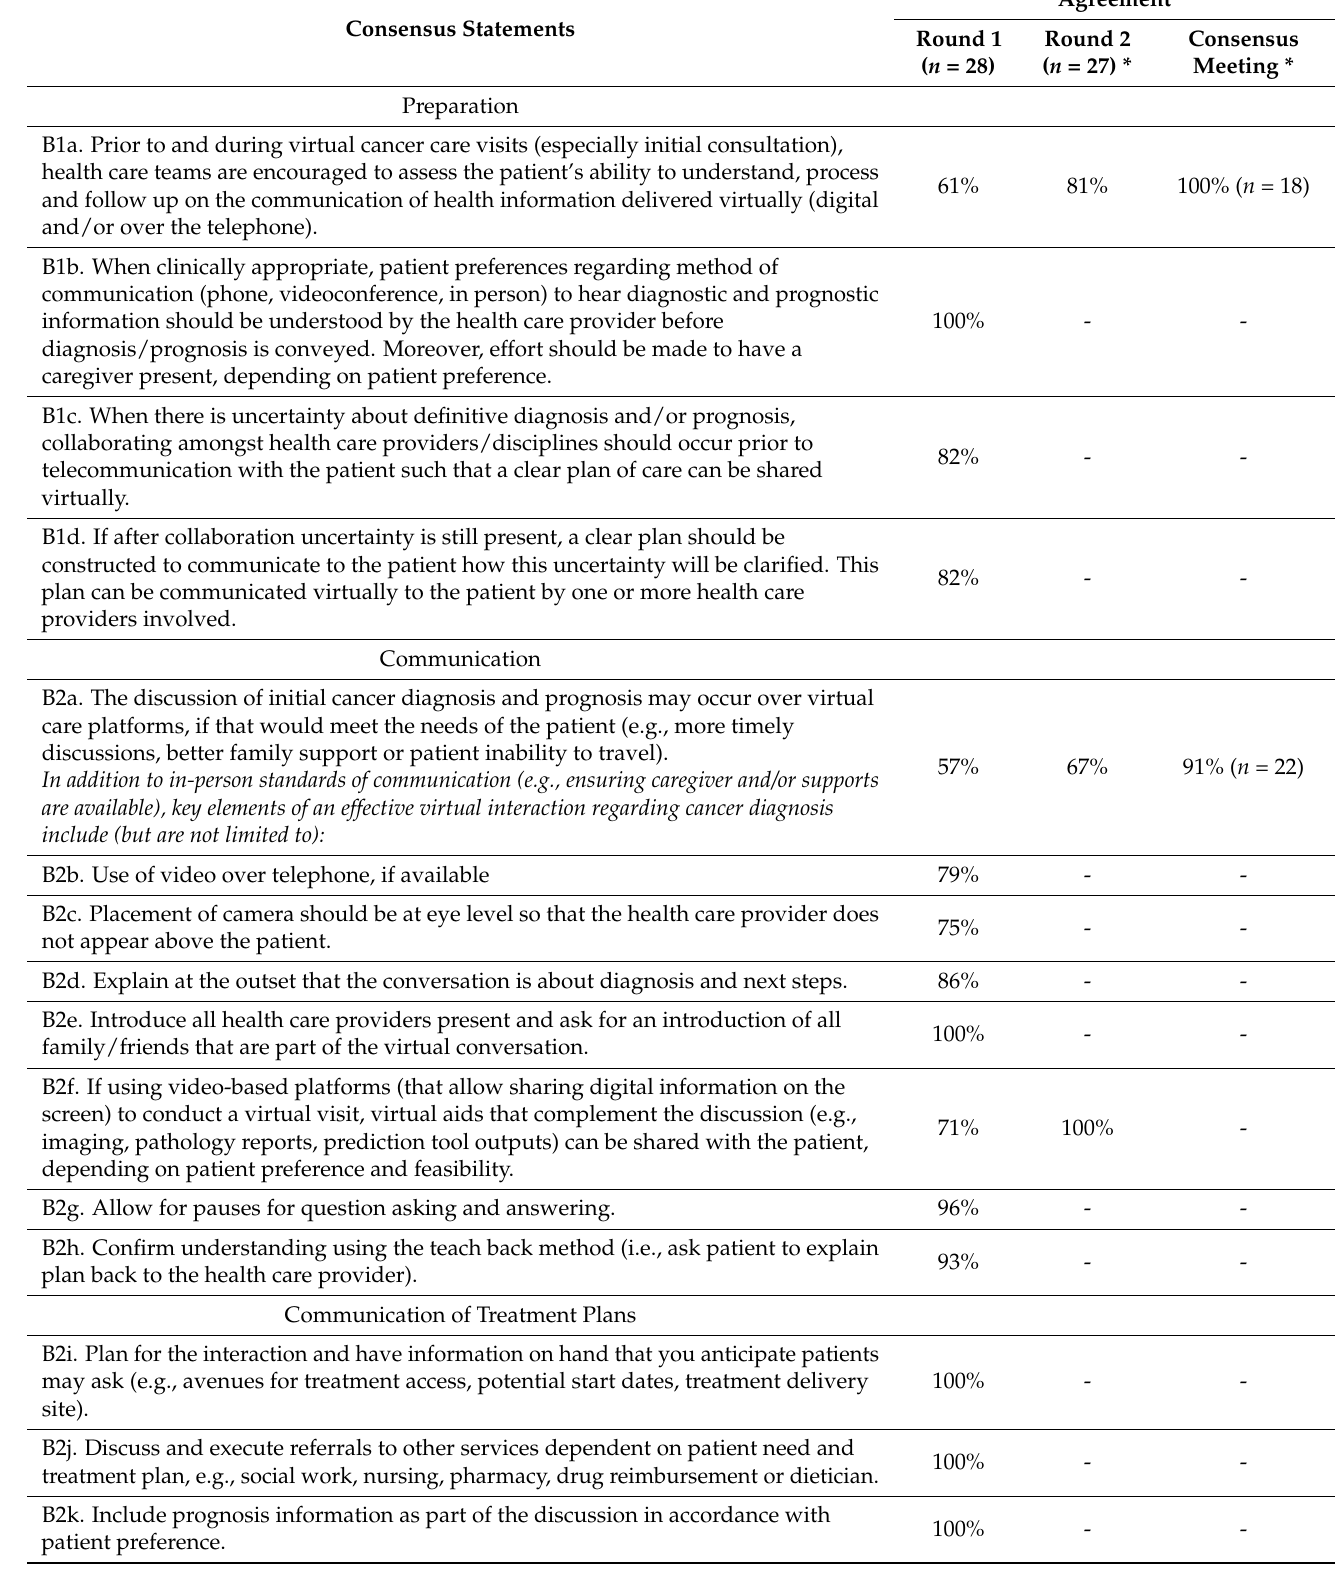
Table 2. Section B—Diagnosis and